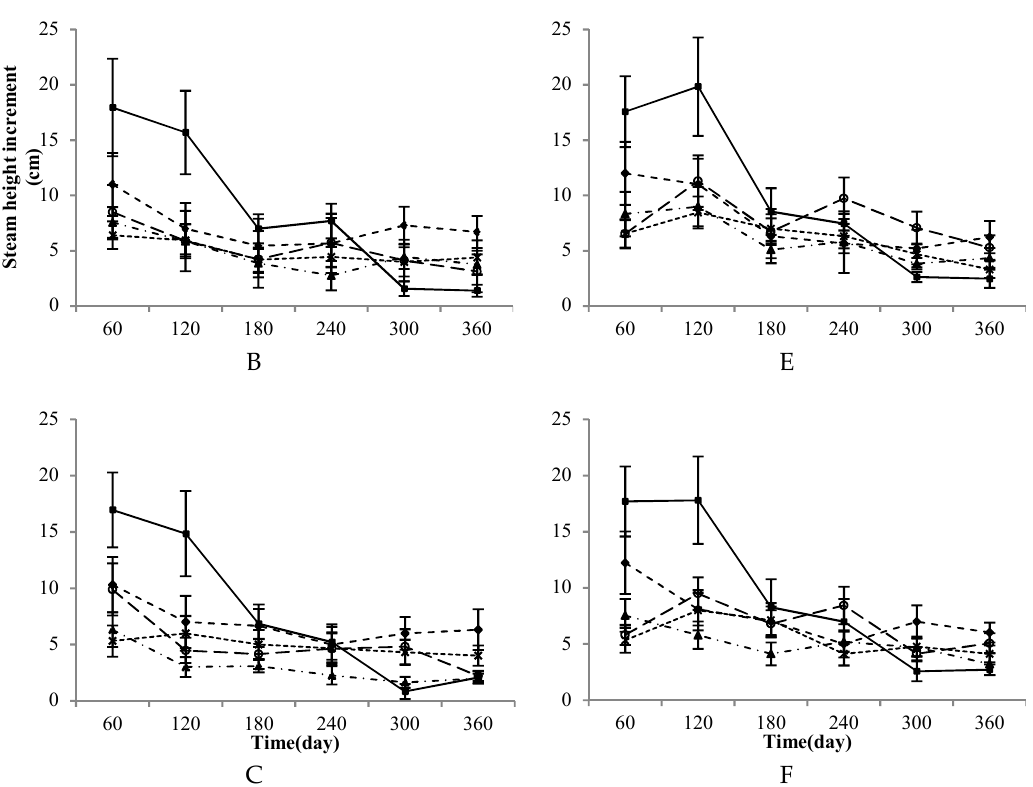
Figure 3. The steam height increment of seedlings of the five mangrove species (Bg = Bruguiera Figure. 3. The steam height increment of seedlings of the five mangrove species ( Bg = gymnorrhiza , Ac = Aegiceras corniculatum , Ko = Kandelia obovata , Rs = Rhizophora stylosa , Am= Avicennia Bruguiera gymnorrhiza , Ac = Aegiceras corniculatum , Ko = Kandelia obovata, Rs = Rhizophora marina ) ( A ) 30% canopy closure and high intertidal elevation, ( B ) 60% canopy closure and high stylosa, Am= Avicennia marina ) ( A ) 30% canopy closure and high intertidal elevation, ( B ) 60% intertidal elevation ( C ) 90% canopy closure and high intertidal elevation, ( D ) 30% canopy closure and canopy closure and high intertidal elevation ( C ) 90% canopy closure and high intertidal low intertidal elevation, ( E ) 60% canopy closure and low intertidal elevation, ( F ) 90% canopy closure elevation, ( D ) 30% canopy closure and low intertidal elevation, ( E ) 60% canopy closure and and low intertidal low intertidal elevation, ( F ) 90% canopy closure and low intertidal elevation. Table 2. F values of two-way ANOVA tests indicating the differences in morphological parameters in varying light levels and intertidal elevation among different mangrove species. Light levels × Intertidal Light levels Intertidal elevation